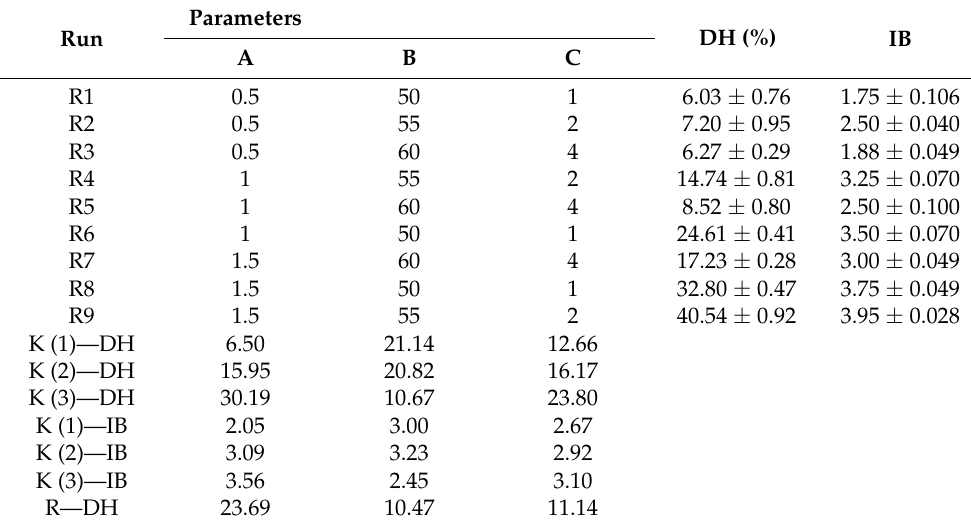
Table 4. The range analysis for the DH and IB obtained for the L9 matrix. Parameters Run